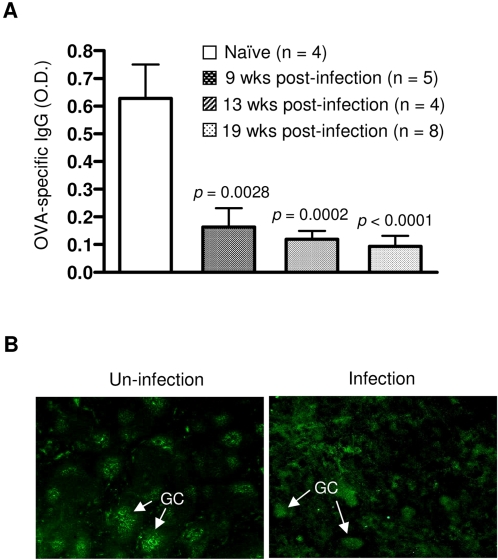

S. japonicum infection impairs the T-cell dependent antibody response.(A) Naïve or infected C57BL/6 mice were injected with 50 µg of OVA. Sera were collected at 12 days after OVA immunization. OVA-specific IgG in sera (1:50 dilution) was measured by ELISA. Data are presented as a mean±SD. p values are shown for the comparison between infected mice at each time point and the uninfected control group. (B) C56BL/6 mice, either uninfected or at 8 weeks post-infection, were challenged with OVA for 12 days. Frozen splenic sections were stained with biotinylated PNA followed by streptavidin-FITC to reveal GCs. Magnification: 40×.